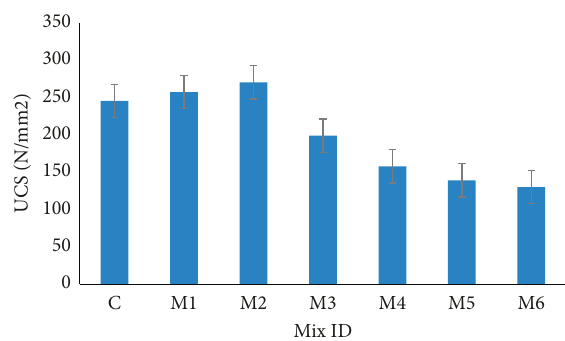
Figure 8: Values from the unconfined compressive strength test.